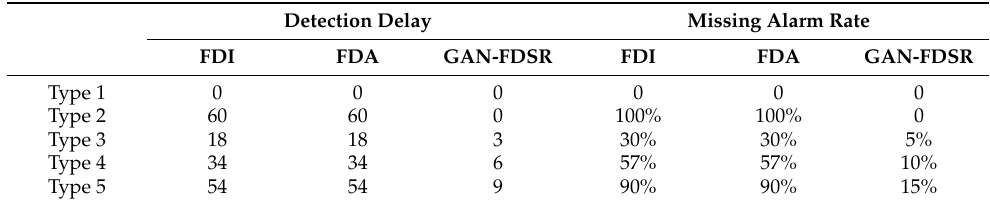
Table 5. Performance of fault